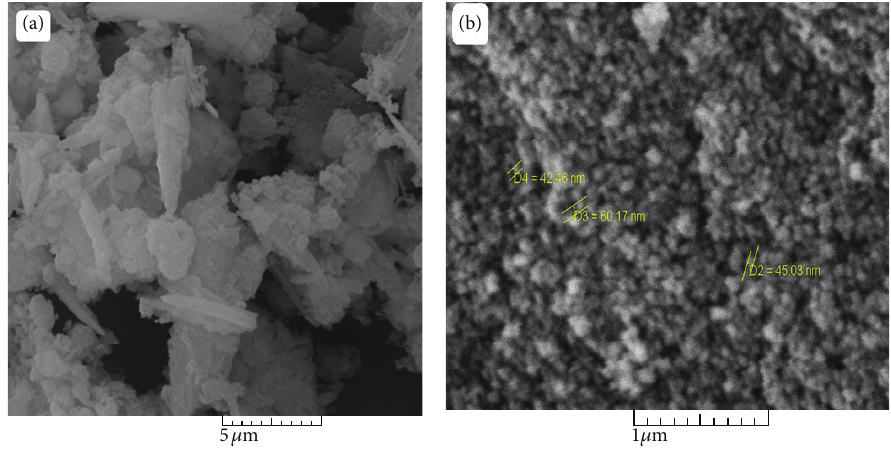
Figure 4: The SEM images of Fe/SiO 2 nanocatalyst, (a) precursor and (b) calcined catalyst.